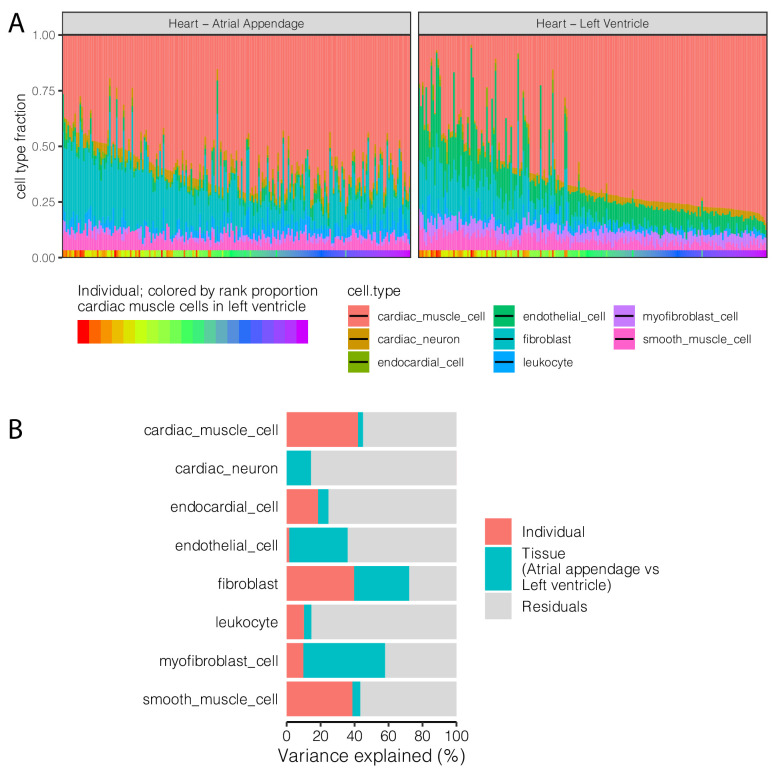
Cell type heterogeneity has a strong non-technical, individual-specific component.(A) Cell type proportion deconvolution (Donovan et al., 2020) for left ventricle and atrial appendage tissue sections from matched individuals. Height of colored bars represents estimates of the proportion of each heart cell type. Individuals are ordered identically in the left ventricle and atrial appendage sub-plots as indicated by the x-axis colorbar. (B) Variance partitioning analysis using a linear mixed model with each term as a mixed effect was used to quantify the contribution of anatomic tissue section and individual to proportion of each cell type.